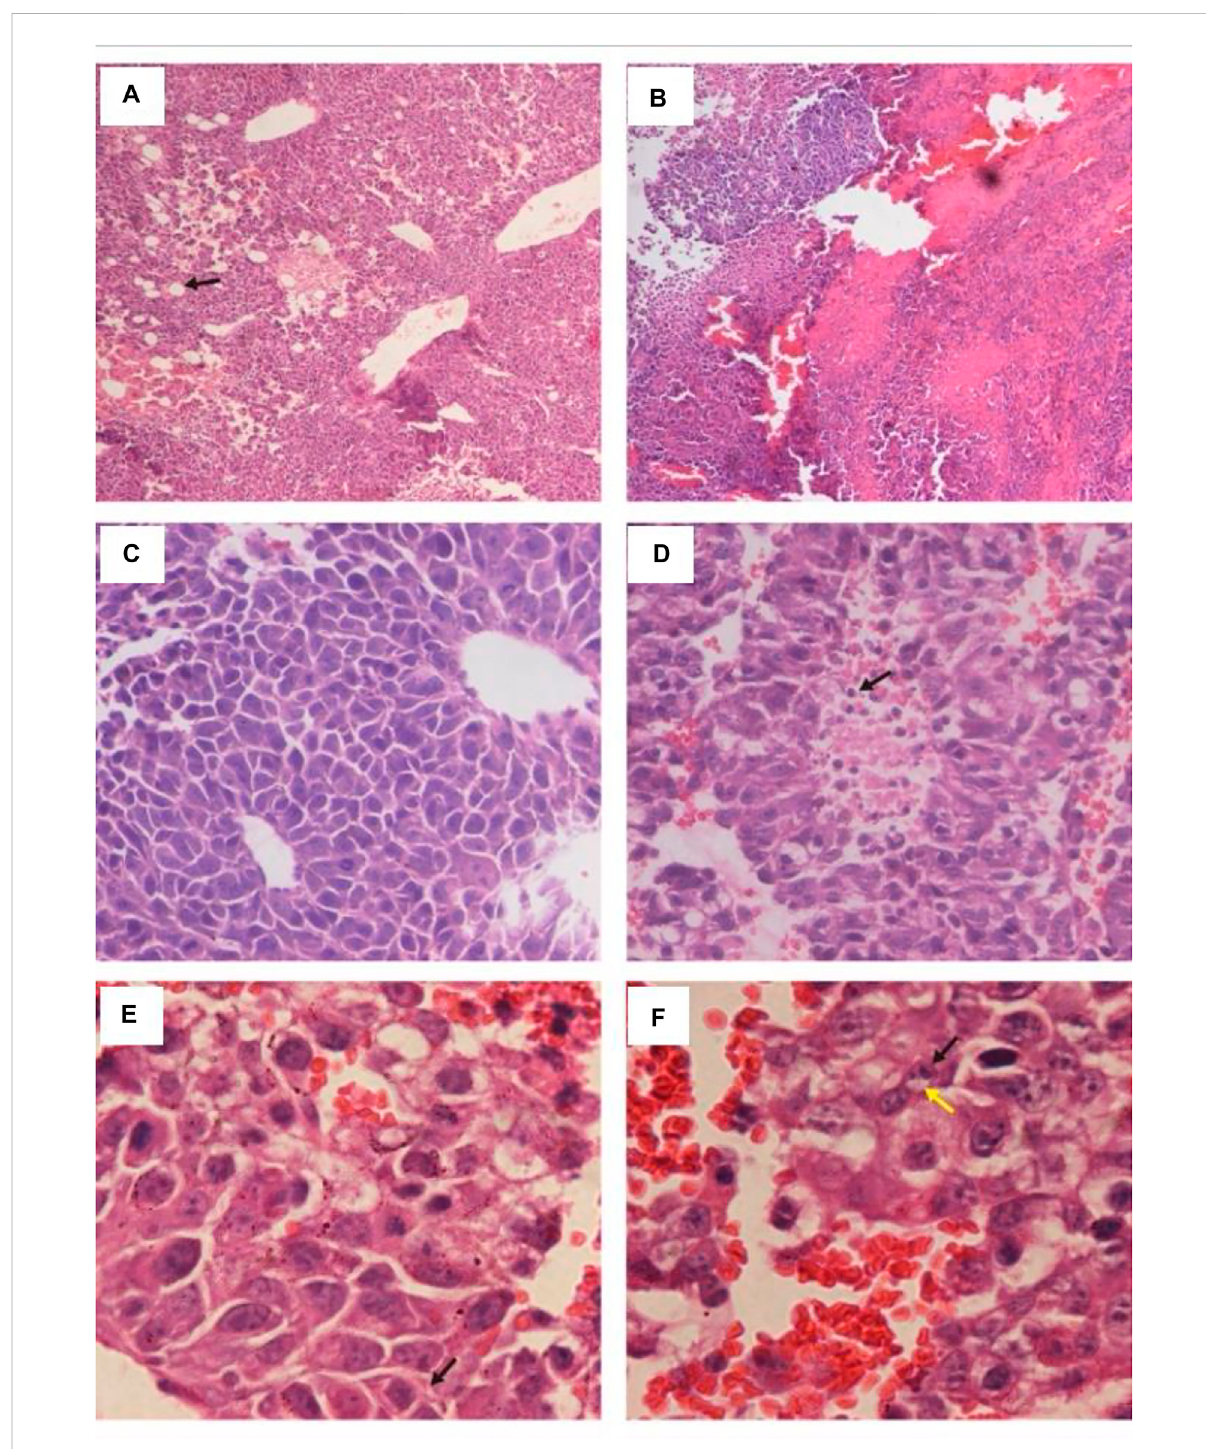
FIGURE 3 HistologyofB16tumorsinjectedwithHN_xs01orPBS.C57BL/CmicebearingB16tumorswereinjectedintratumorallywith1×10 8 CFU/100 μ